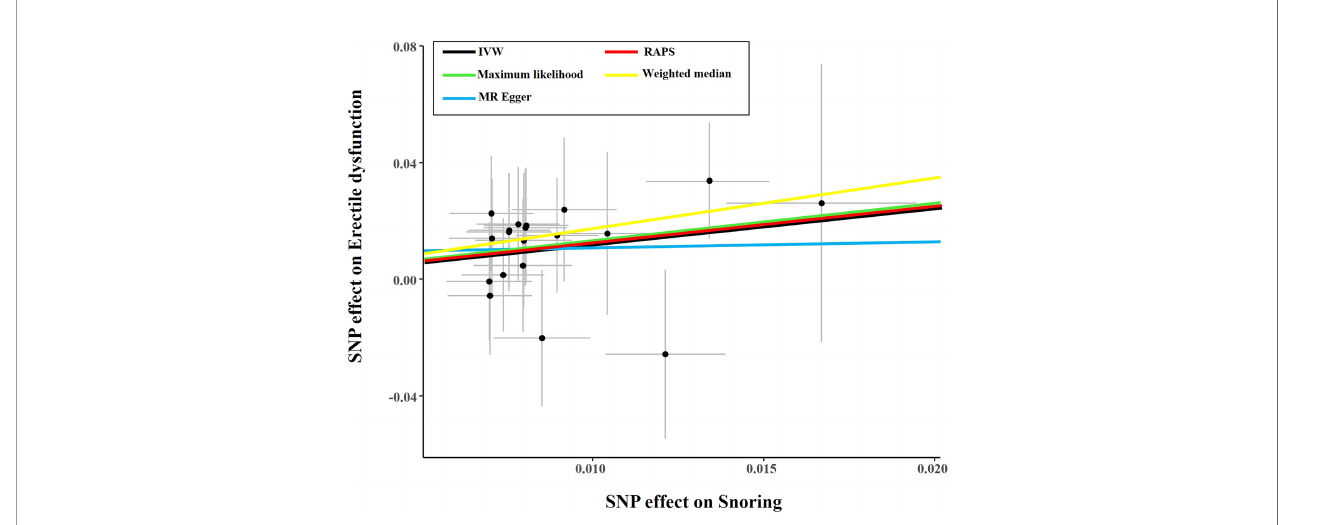
FIGURE 2 | Scatter plot of the effect size of each SNP on snoring and ED in SVMR. SNP, single nucleotide polymorphism; IVW, Inverse variance weighted method; ED, erectile dysfunction; MR, mendelian randomization; SVMR, single-variable mendelian randomization.